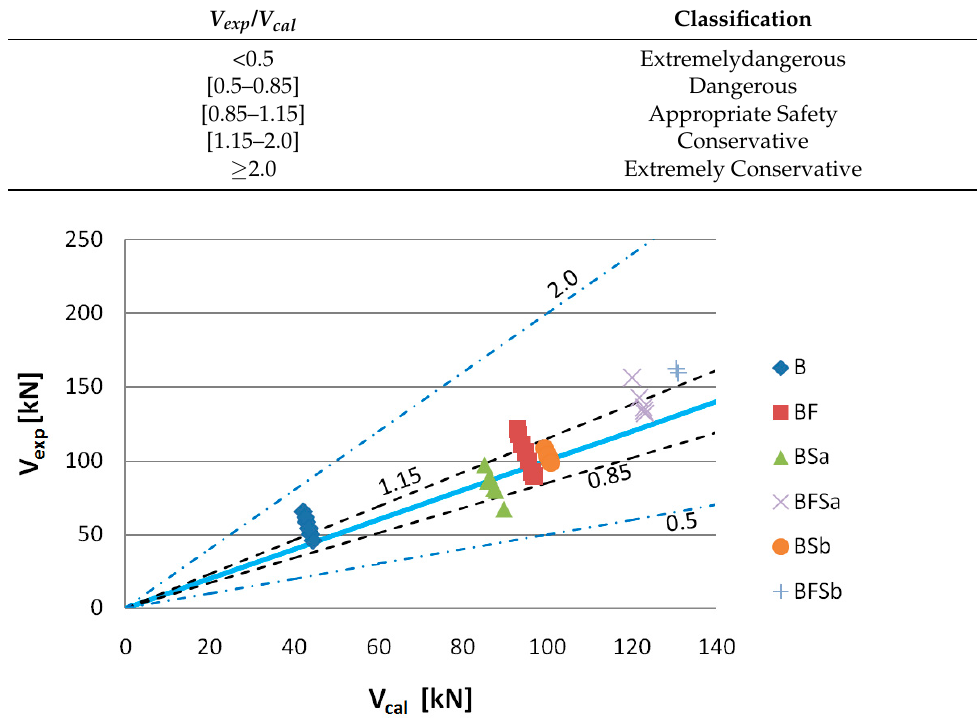
Figure 22. Values of experimentally fixed ( V exp ) versus computational ( V cal ) shear capacity deter- mined according to Model Code using the SMCFT method ( θ = min θ ).